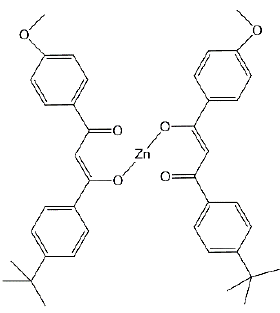
Figure 2. Structure of zinc 1-( 4′ -t-butylphenyl)-3- (4“ -methoxyphenyl)propane-1,3-dione (tBuM- BPP-Zn).